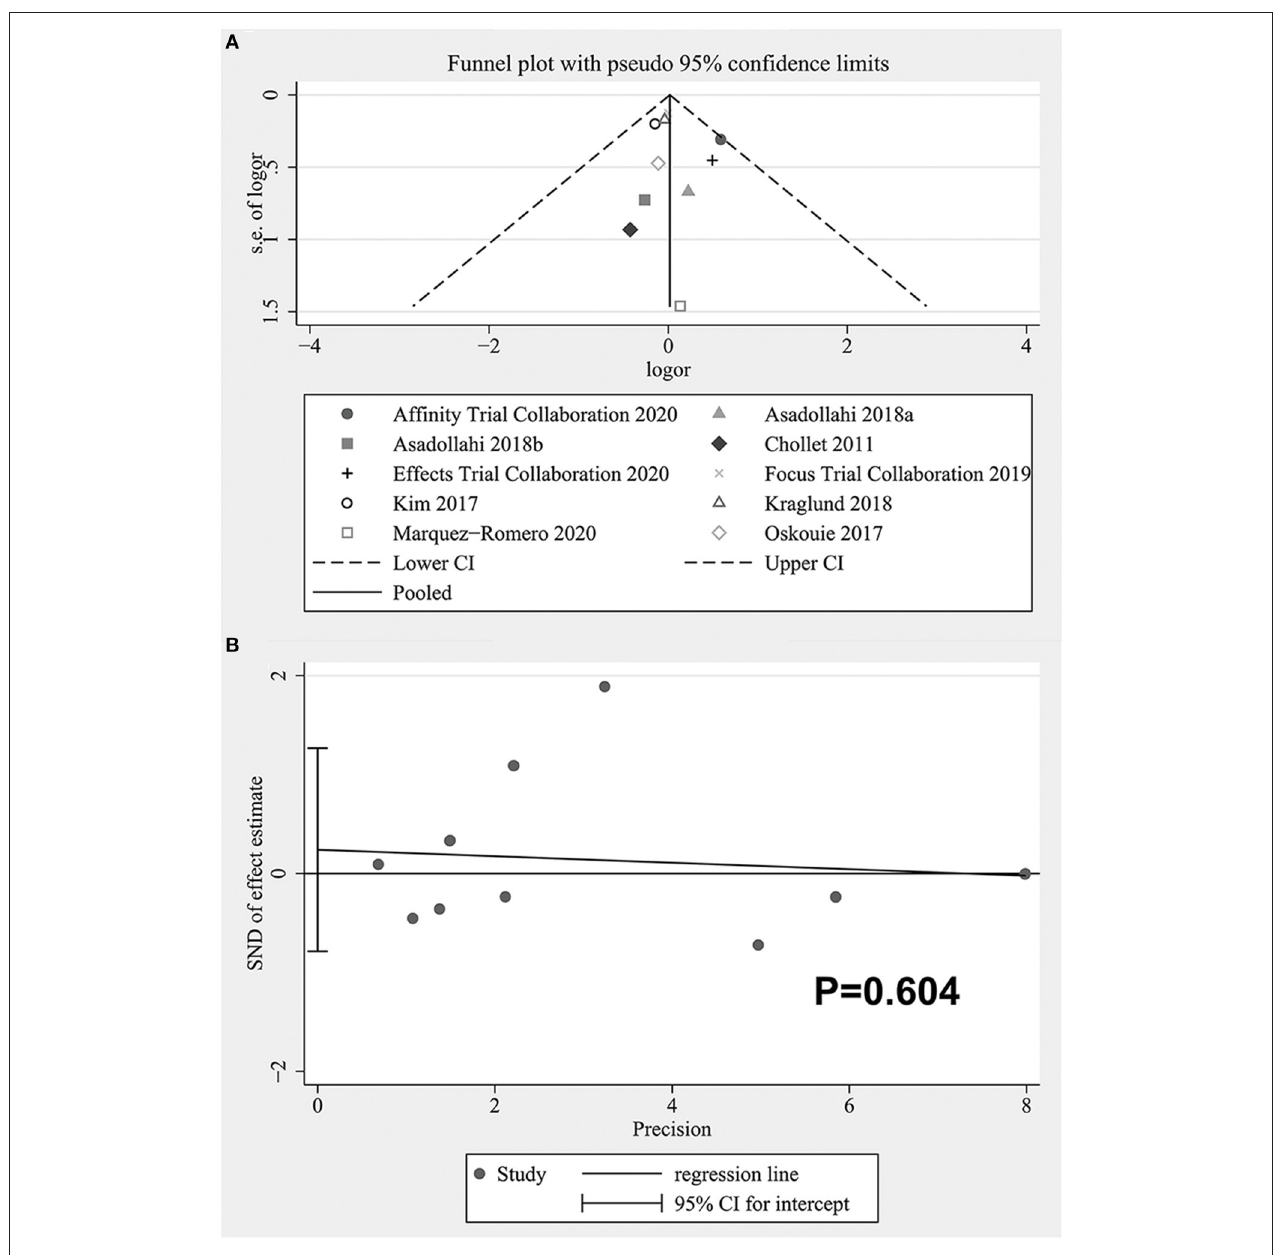
FIGURE 8 | (A) The funnel plot of publication bias, (B) Egger’s test of publication